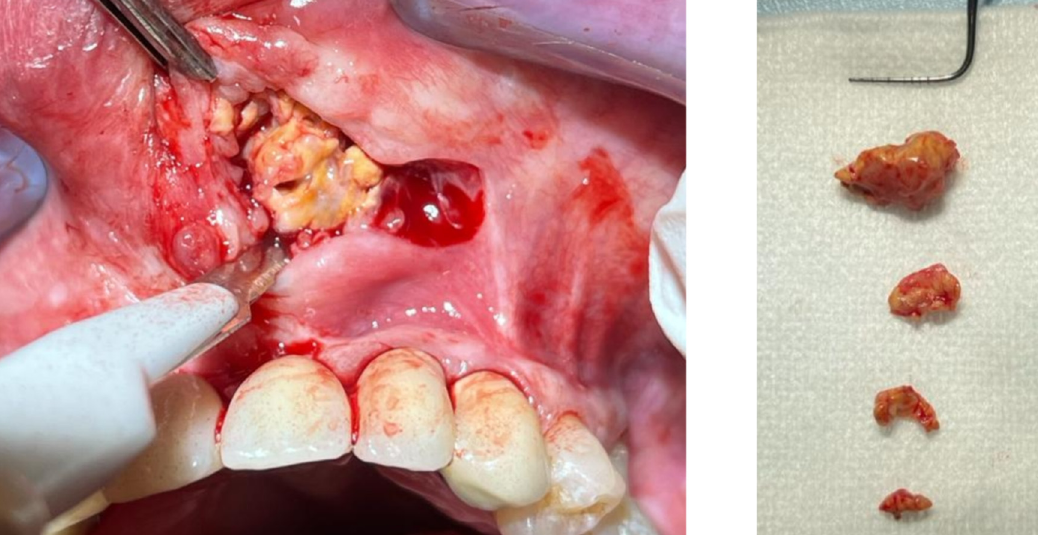
Fig. 2. Excision biopsy showing a rather well de fi ned yellow tissue lesion surrounded by in fl ammatory tissue, located in the labial